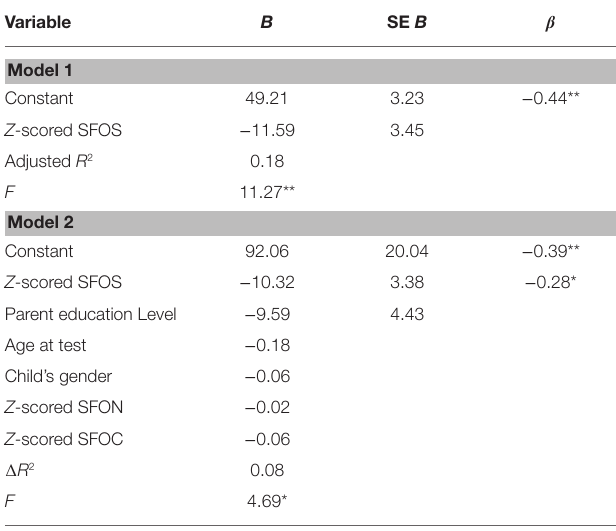
TABLE 6 | Summary of linear step-wise regression analysis for six variables (child’s age at test, gender, parental education level, z -scored SFON, z -scored SFOC, and z -scored SFOS) predicting performance on the proportional scaling